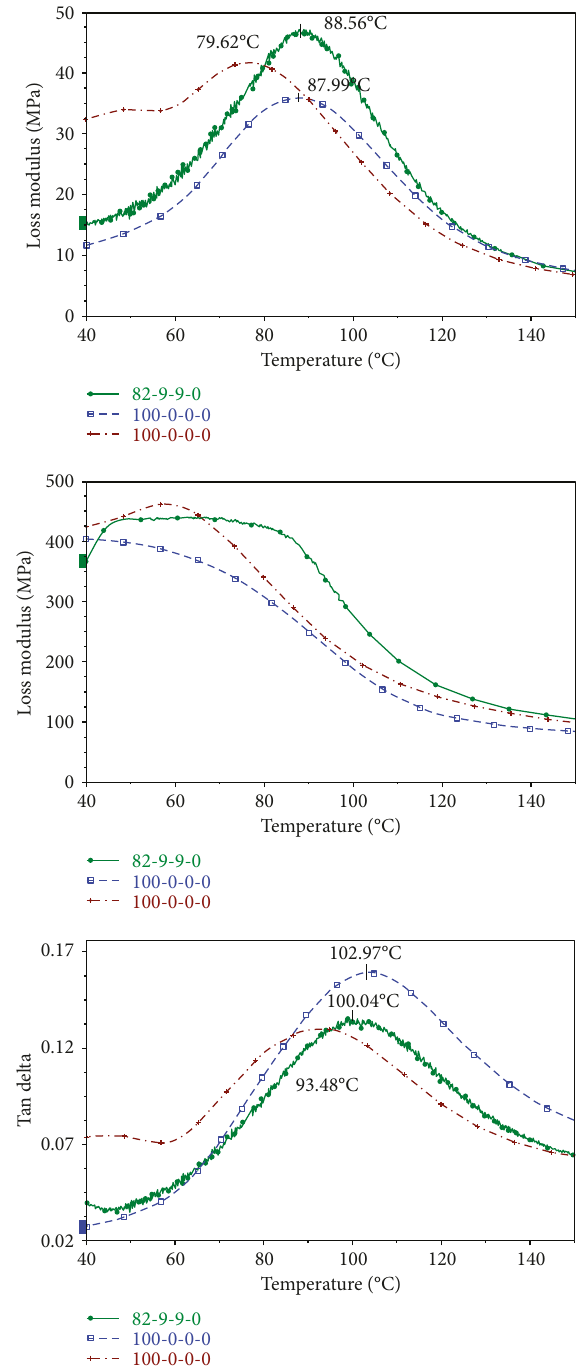
Figure 2: Loss modulus, storage modulus, and tan delta for the composites prepared from the new solvents.